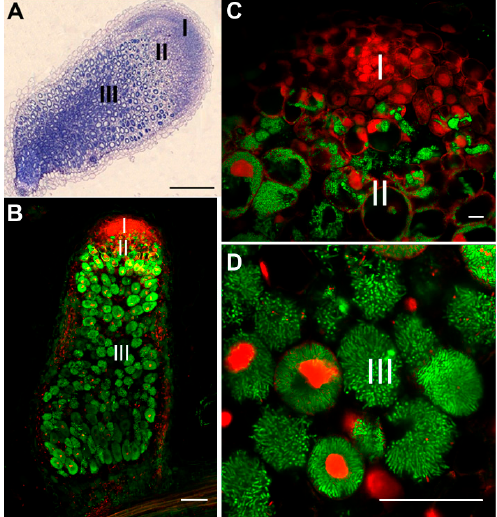
Figure 1. The indeterminate root nodule structure in Medicago truncatula . ( A ) Longitudinal section of indeterminate nodule 3 weeks post infection (wpi) with the apical meristem (I), the infection zone (II), and the nitrogen-fixing zone (III). ( B – D ) Longitudinal section of wild-type nodules 3 wpi analyzed by confocal microscopy with S. meliloti DNA stained with SYTO9 (green) and plant nuclei stained with propidium iodide (red) [8]. ( C ) The size of plant cells and of plant cell nuclei increases during cellular differentiation and intracellular bacterial infection occurs in zone II. ( D ) The nitrogen-fixing cells in zone III are fully packed with numerous elongated endosymbiotic bacteria called symbiosomes. Bars: ( A ) 200 µm; ( B ) 100 µm; ( C ) 10 µm; ( D ) 50 µm.